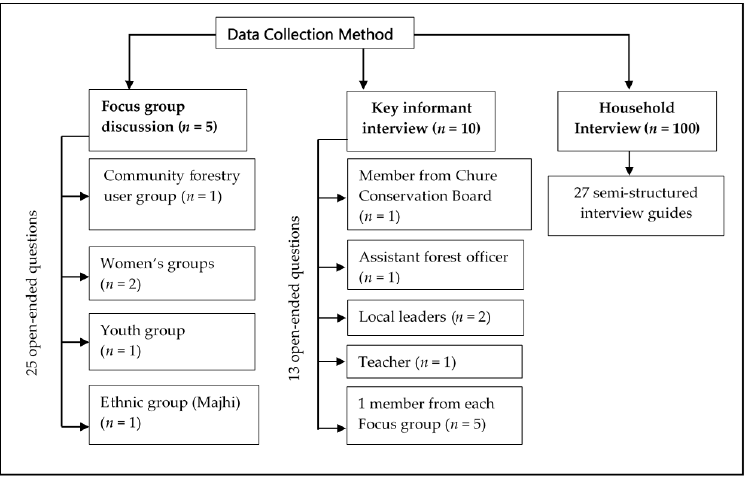
Figure 2. Data collection chart showing the distribution of focus group discussions, household survey and key informant interviews.